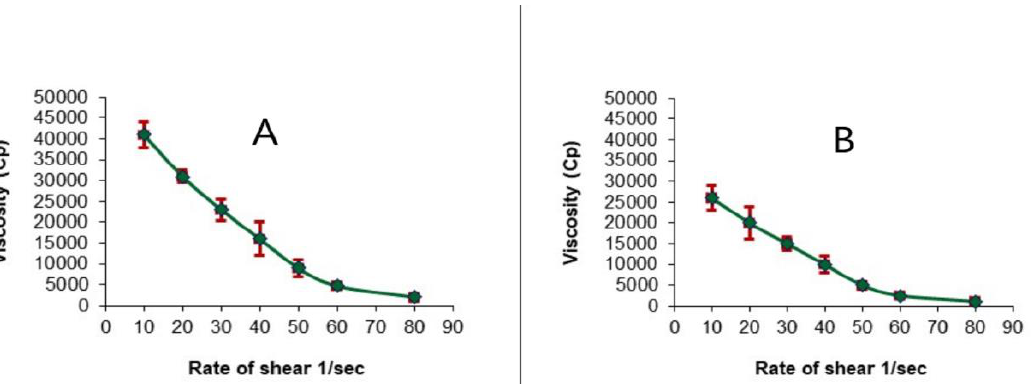
Figure 5. Plots of the shear rate (G) versus the viscosity ( η ) for ( A ) nanoemulgel loaded with optimized LV-Eu-SNEDDS and ( B ) Carbopol 934 hydrogel (plain). Values are expressed as the mean ± SD ( n = 3).